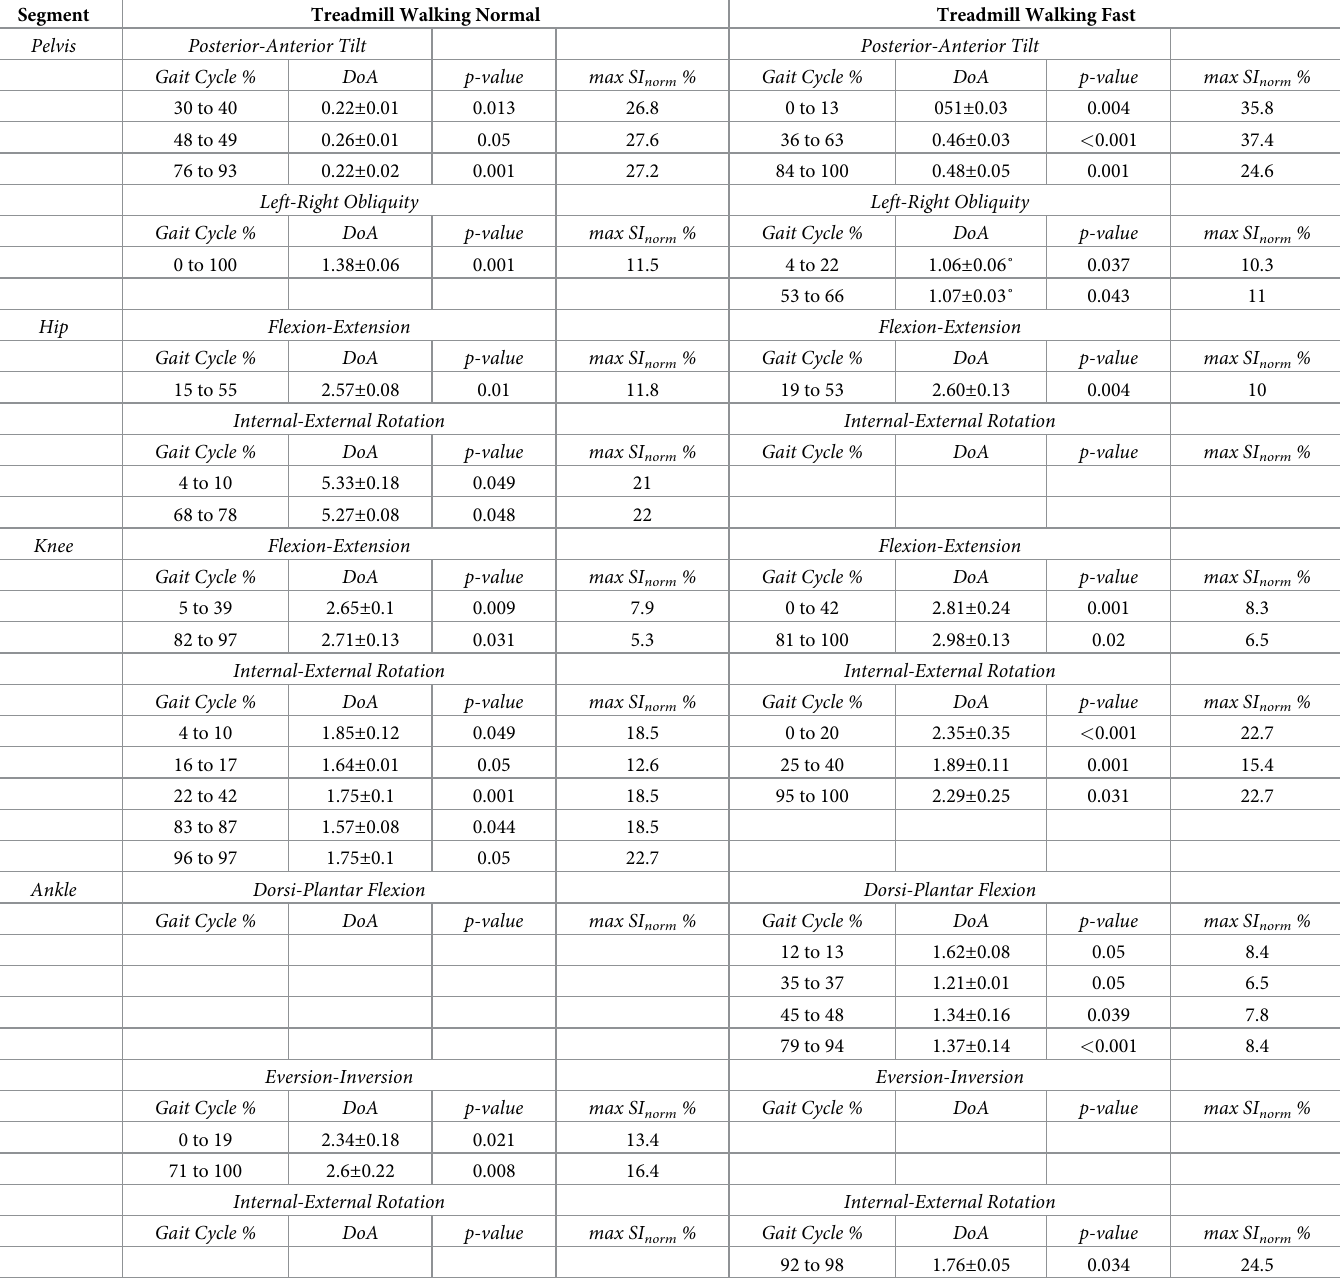
Table 2. Average and standard deviation of the degree of asymmetry and maximum magnitude of the normalized symmetry index between the associated left and right motions in the pelvis segment and the lower body joints during normal and fast treadmill walking of N = 60 participants.